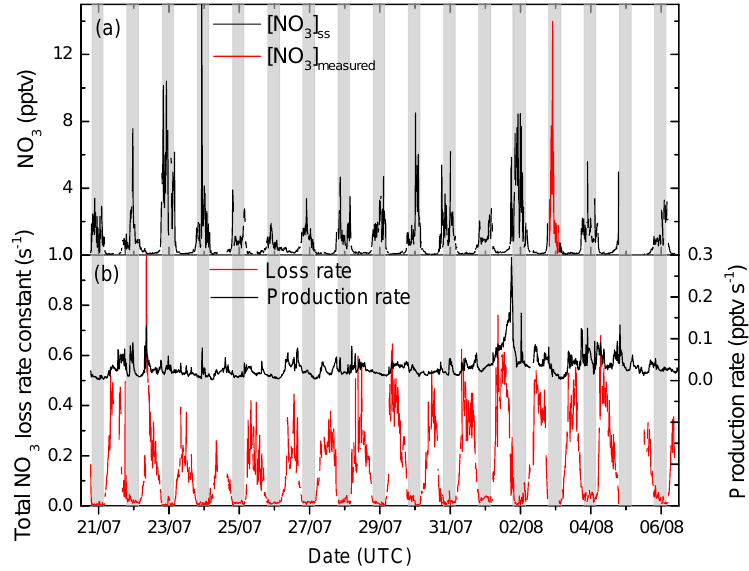
, [NO] k 3 , K 5 [NO 2 ] f het , and J NO for the entire campaign and OTG 3